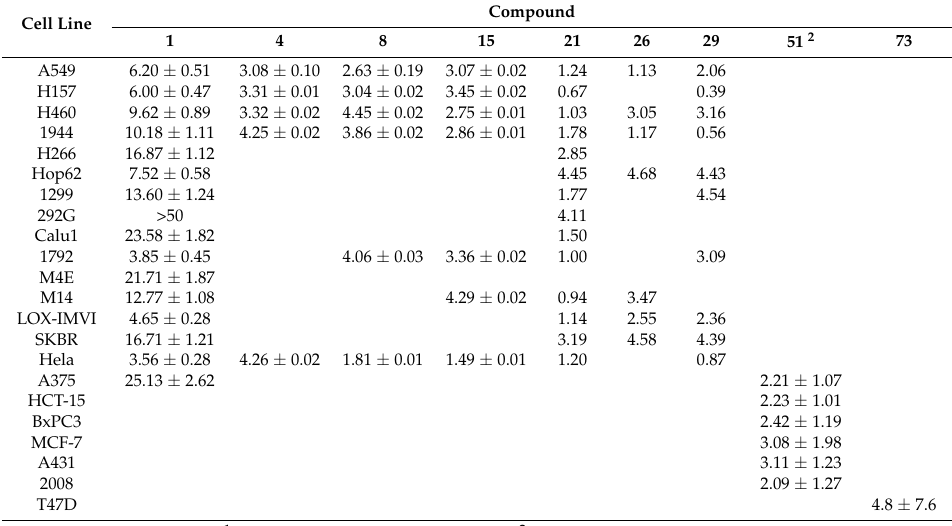
Table 19. Anticancer activity of the most promising quercetin analogs compared to quercetin 1 . Cell